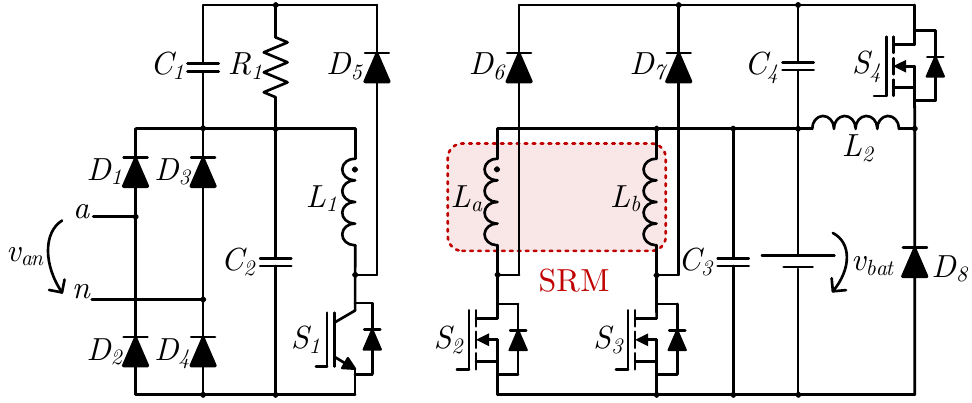
Figure 6. EV IBC based on SRMs proposed by C. Pollock and W. K. Thong in 2000 [18].